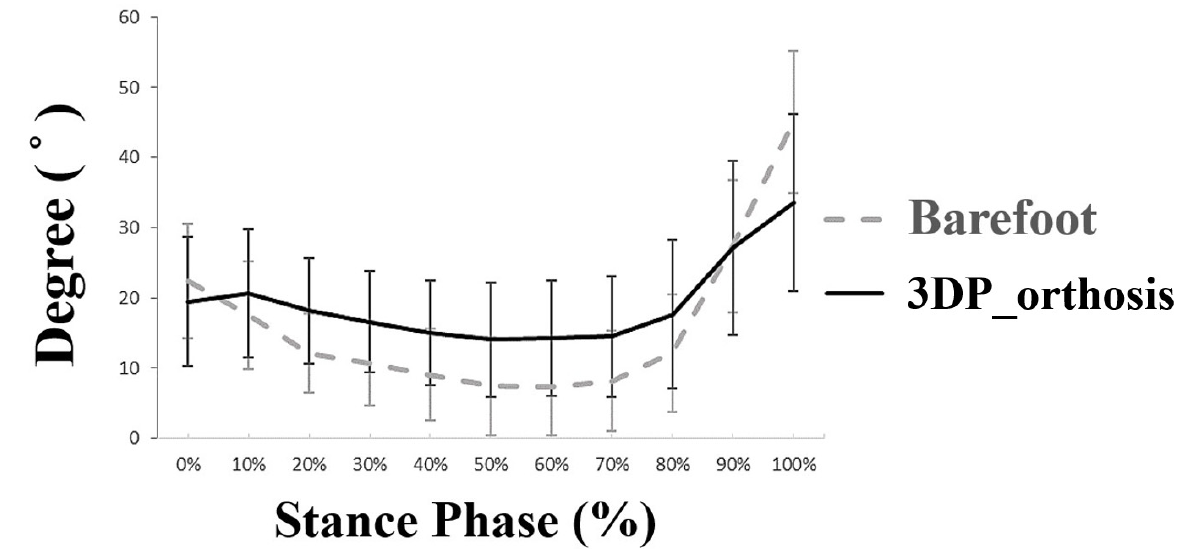
Figure 4. Variation in dorsiflexion angles during the stance phase of gait.